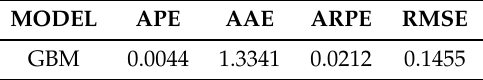
Table 7. Prediction error by geometric Brownian motion.